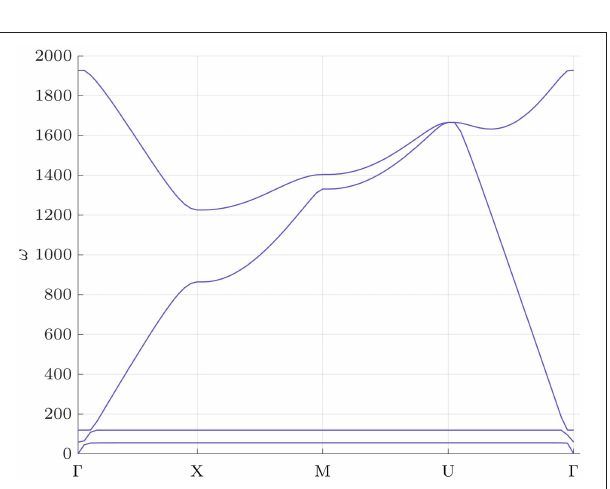
1m) of double = k ( m − 1 ), projection of the = | | [55.2128,58.5863] rad.s − 1 ∈